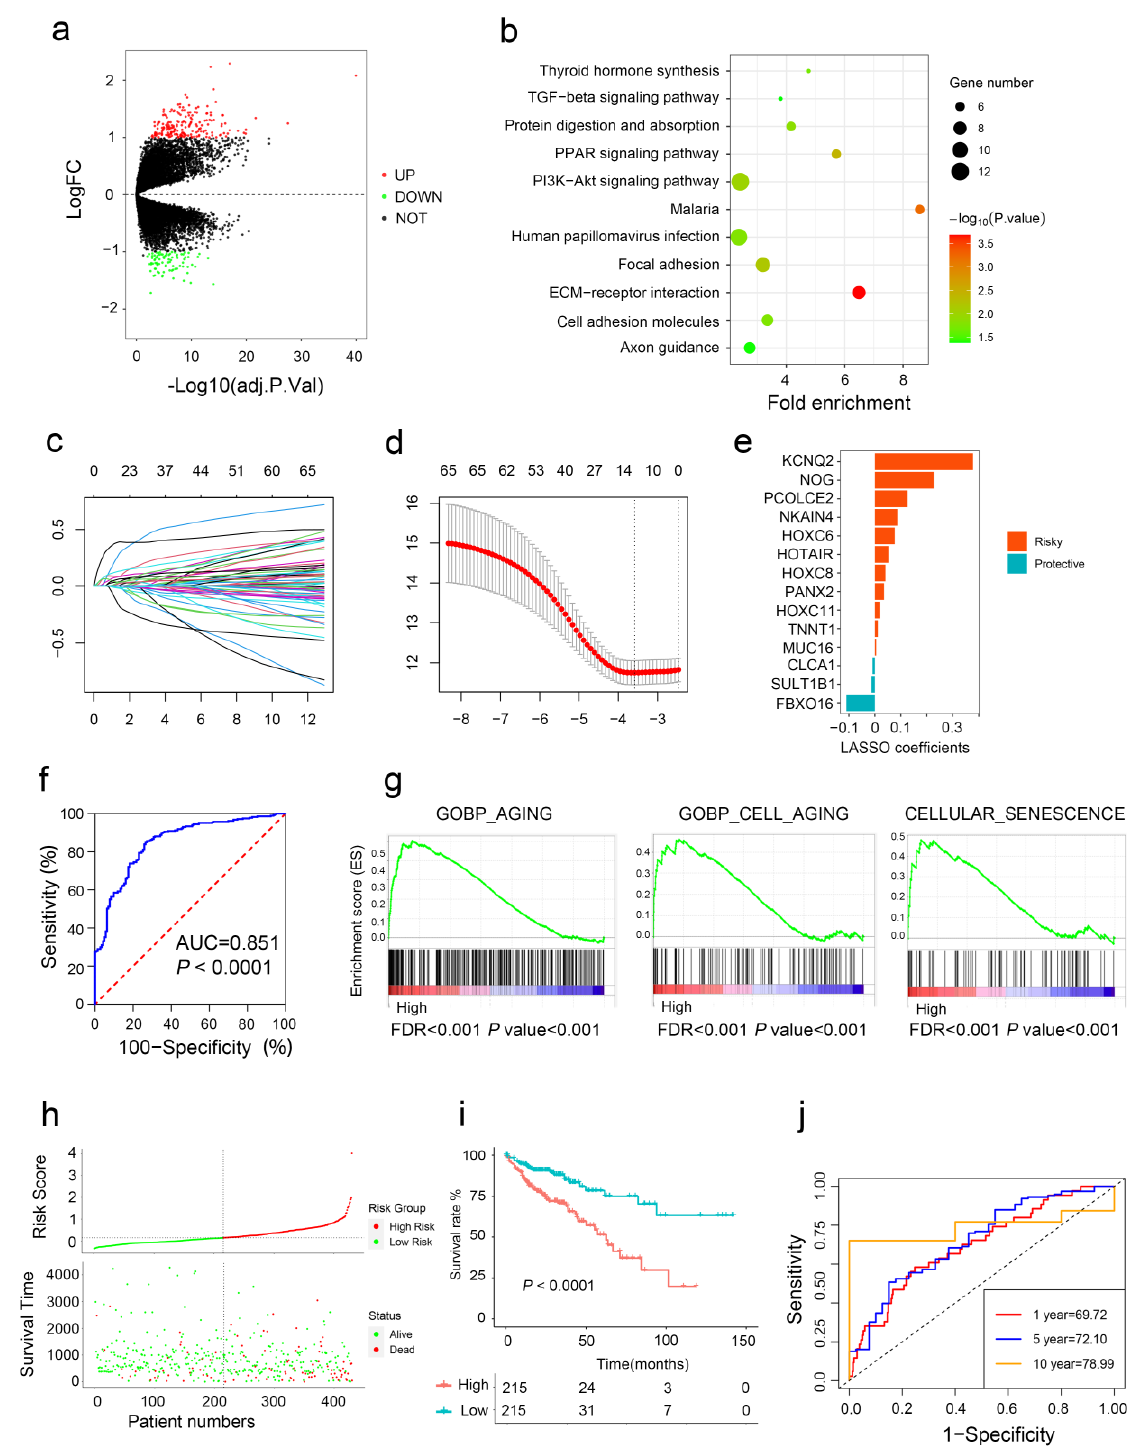
Figure 5. Construction of aging-related risk score to predict CRC prognosis. ( a ) Volcano plots show DEGs between the two subtypes. ( b ) Bubble chart shows the functional enrichment results of DEGs. ( c , d ) Aging-related risk score models were constructed using least absolute shrinkage and LASSO methods. ( e ) LASSO coefficients of the 14 aging-related genes. ( f ) ROC curves for predicting aging subtypes by risk score. ( g ) GSEA of aging pathway in high- and low-risk groups. ( h , i ) The association of high-risk score with prognosis of CRC patients. ( j ) ROC curves for predicting 1-, 5-, and 10-year OS by risk score.